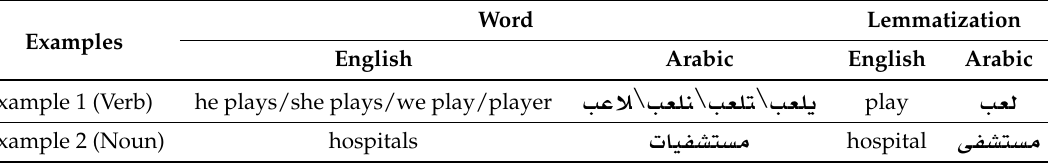
Table 2. Examples of word lemmatization in Arabic and their corresponding English